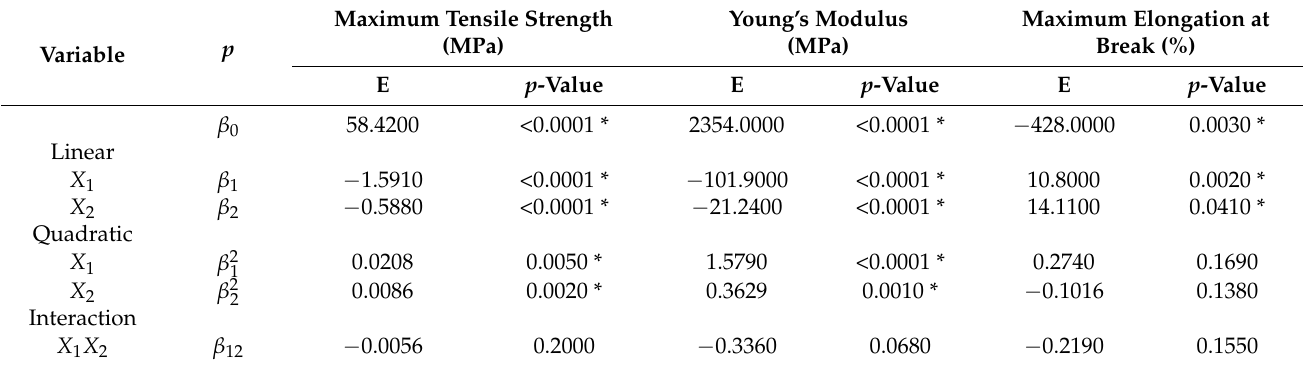
Table 3. Analysis of variance for regression coefficients of mechanical